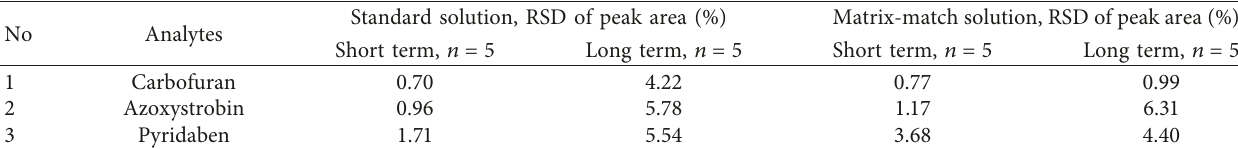
Table 3: Short-term and long-term repeatability of the analytical signal (peak area) of target analytes in UPLC-Orbitrap MS. No